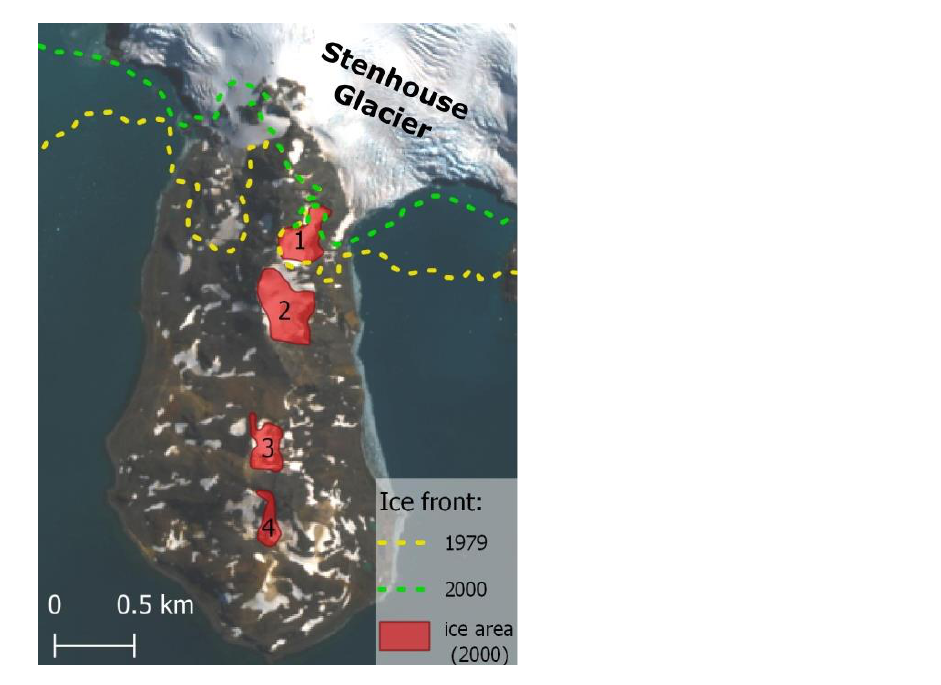
Figure 12. Areas of four glaciers (1 — Babylon, 2 — Ferguson, 3 — Flagstaff, and 4 — Noble) in 2000. The locations of the front of Stenhouse Glacier are shown in 1979 and 2000. The background image is based on a Sentinel 2 satellite image (acquired on 19 January 2020), based on Simões et al. [67].